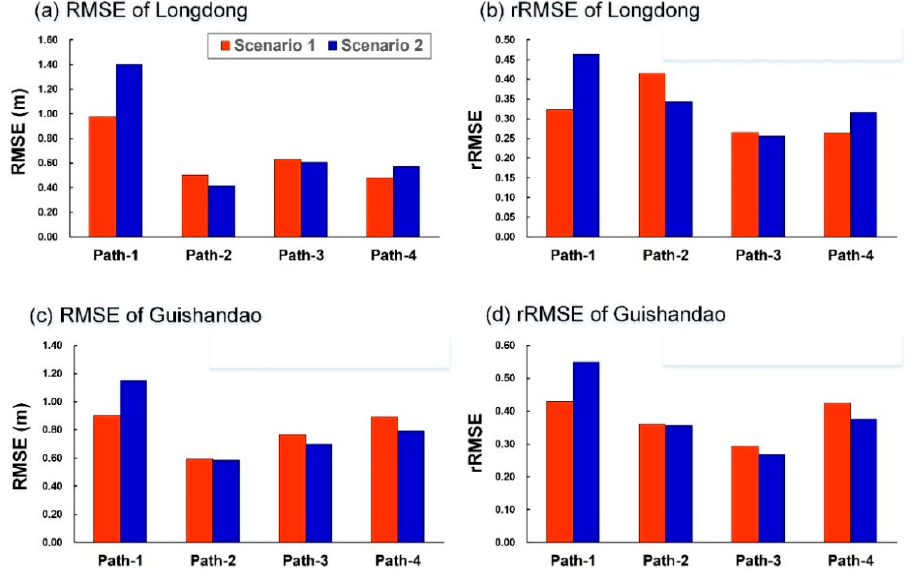
Figure 11. The values of RMSE ( a , c ) and rRMSE ( b , d ) for Longdong and Guishandao according to typhoon path.